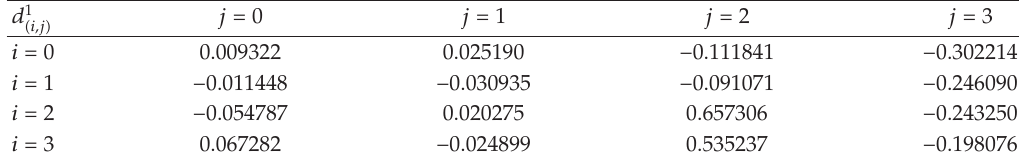
Table 2: The coe ffi cients of a high-pass wavelet filter (cid:3) d 1 (cid:3) i,j (cid:4) (cid:4) associated with the low-pass wavelet filter in Table